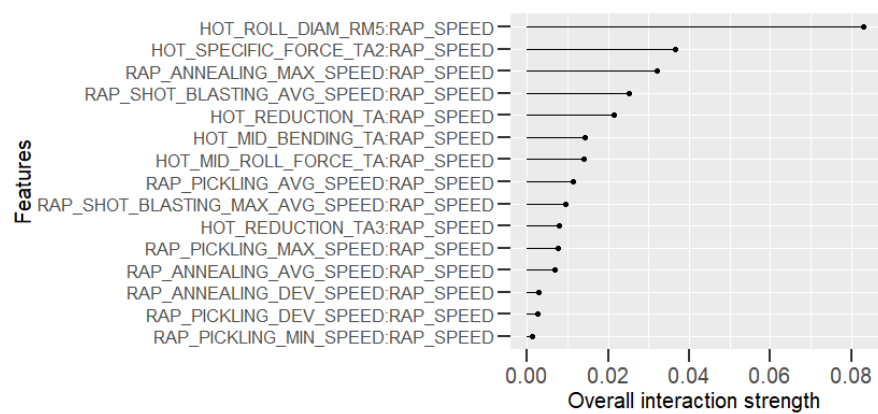
Figure 7. The strength of the interactions of the variables.